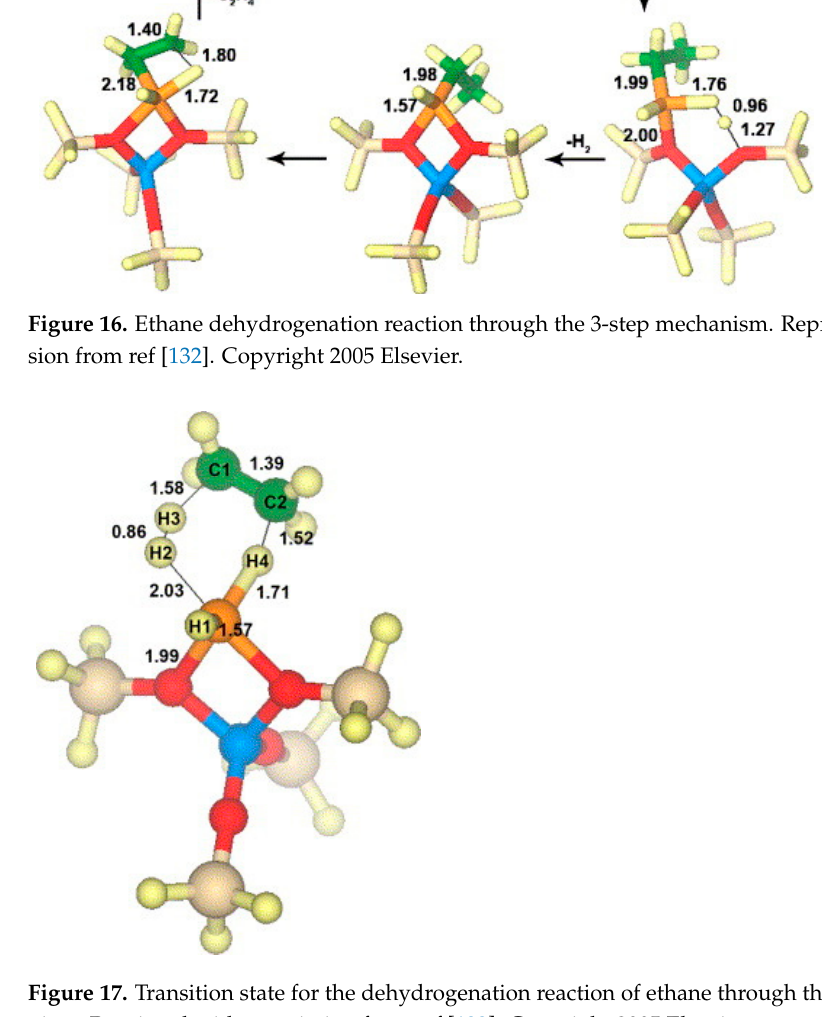
Figure 18. Dehydrogenation reaction of ethane through the three-step mechanism computed with GaH 2 species and T22 cluster (B3LYP/6-31G**). Reprinted with permission from ref [133]. Copy- right 2008 American Chemical Society.